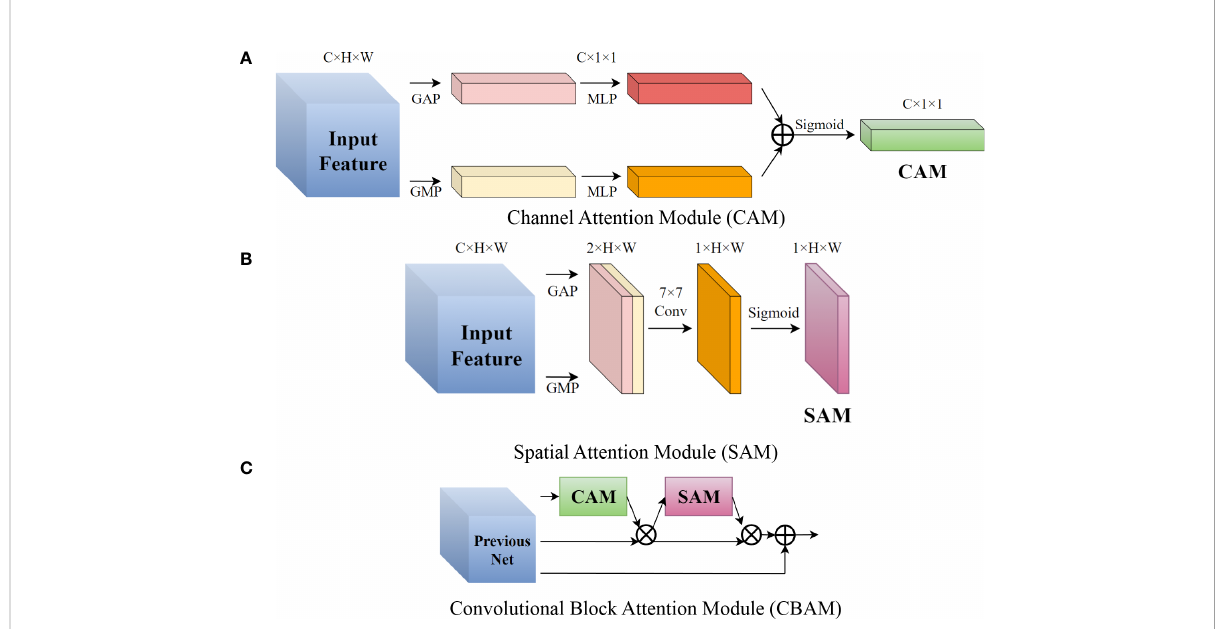
FIGURE 6 Schematic diagram of the CBAM structure in YOLO-P. (A) Channel Attention Module (CAM) (B) Spatial Attention Module (SAM) (C) Convolutional Block Attention Module